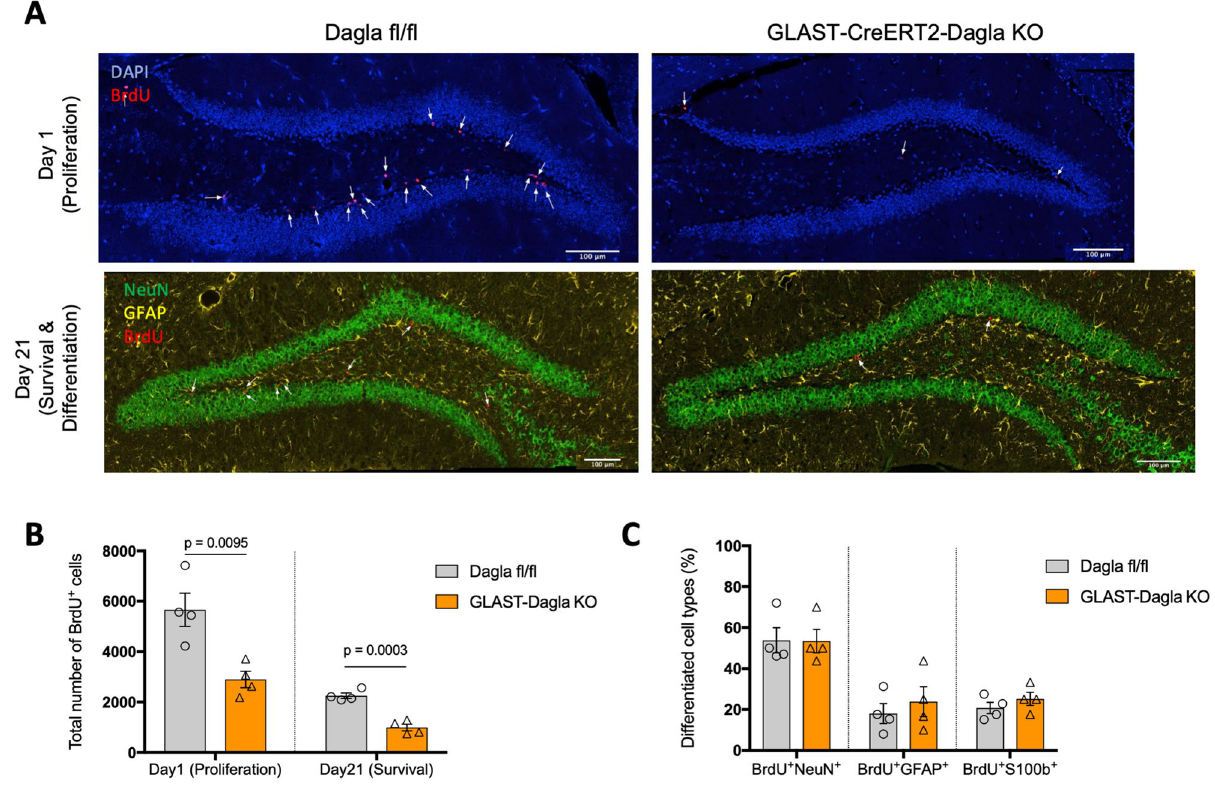
Figure 4. Adult hippocampal neurogenesis is impaired in GLAST-CreERT2-Dagla KO mice. ( A ) Representative immunohistochemistry micrographs of GLAST-CreERT2-Dagla WT and KO mice one or 21 days after BrdU injections in dentate gyrus to study proliferation and survival/differentiation, respectively (blue: DAPI; red: BrdU; green: NeuN; yellow: GFAP; scale bar: 100 µm). ( B ) The number of BrdU-positive cells in dentate gyrus of GLAST-CreERT2-Dagla KO mice was significantly lower compared to WT controls one day ( p = 0.0095) as well as 21 days ( p = 0.0003) after BrdU injections. ( C ) To analyze differentiation of progenitor cells, co-expression of BrdU-positive cells with neuronal marker (NeuN) or astrocytic marker (GFAP and S100) on day 21 were quantified. There were no changes in differentiation between GLAST-CreERT2-Dagla KO and WT control mice. Values represent mean ± SEM; n = 4 animals/group; 6 analyzed pictures per animal. Student’s